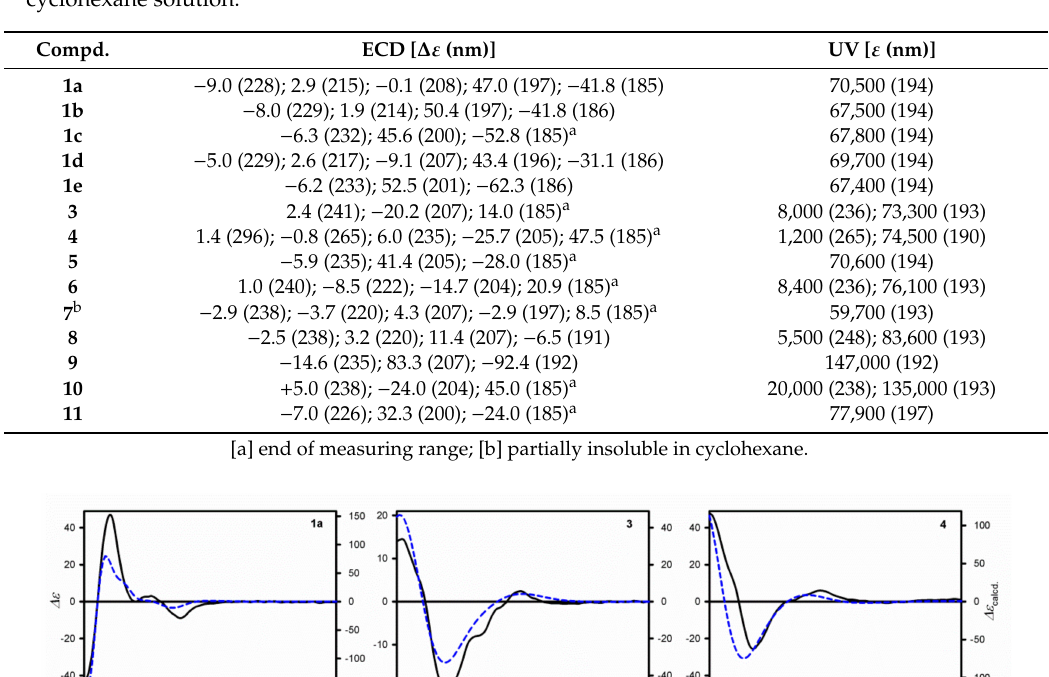
Table 1. Electronic circular dichroism (ECD) ( ∆ ε ) and UV ( ε ) data for derivatives 1 , 3 – 11 measured in cyclohexane solution.